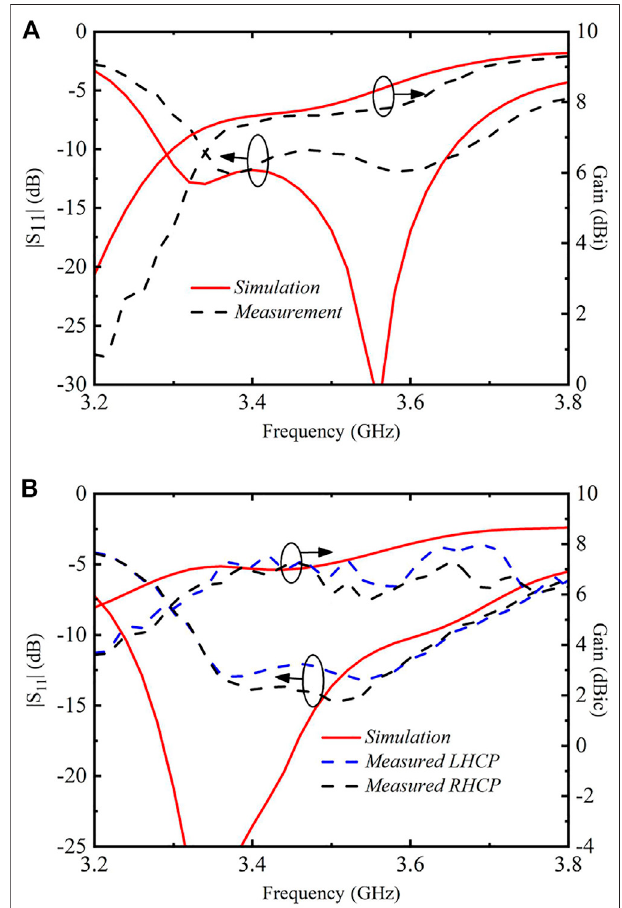
FIGURE 6 | Simulated and measured re fl ection coef fi cients and broadside gains of the proposed antenna: (A) LP state; (B) CP states.